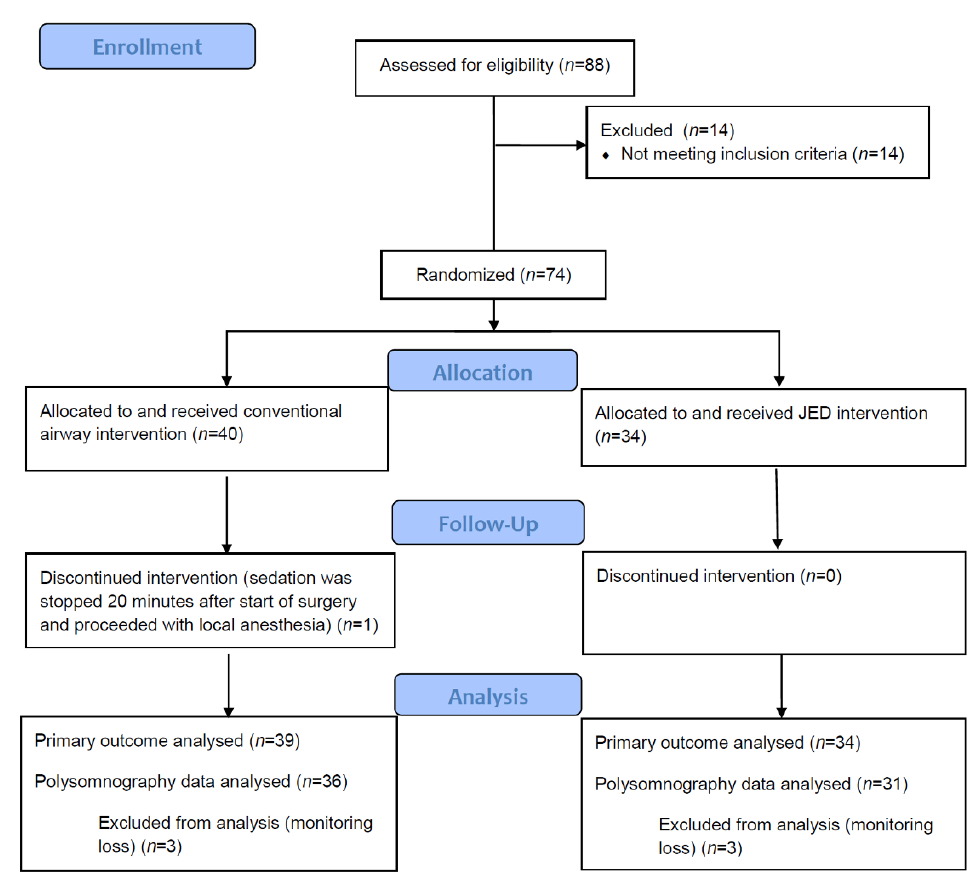
Figure 2. CONSORT flow diagram. Table 2. Intraoperative sedation data. Table 1. Patient characteristics and preoperative survey